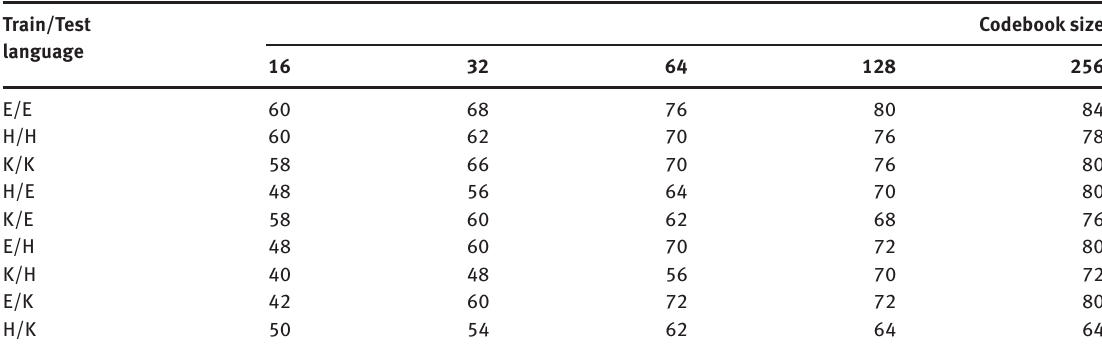
Table 3: Speaker Identification Performance (%) for the 50 Speakers of Our Own Database Using 20-s Training and Testing Data for the LVQ Modeling